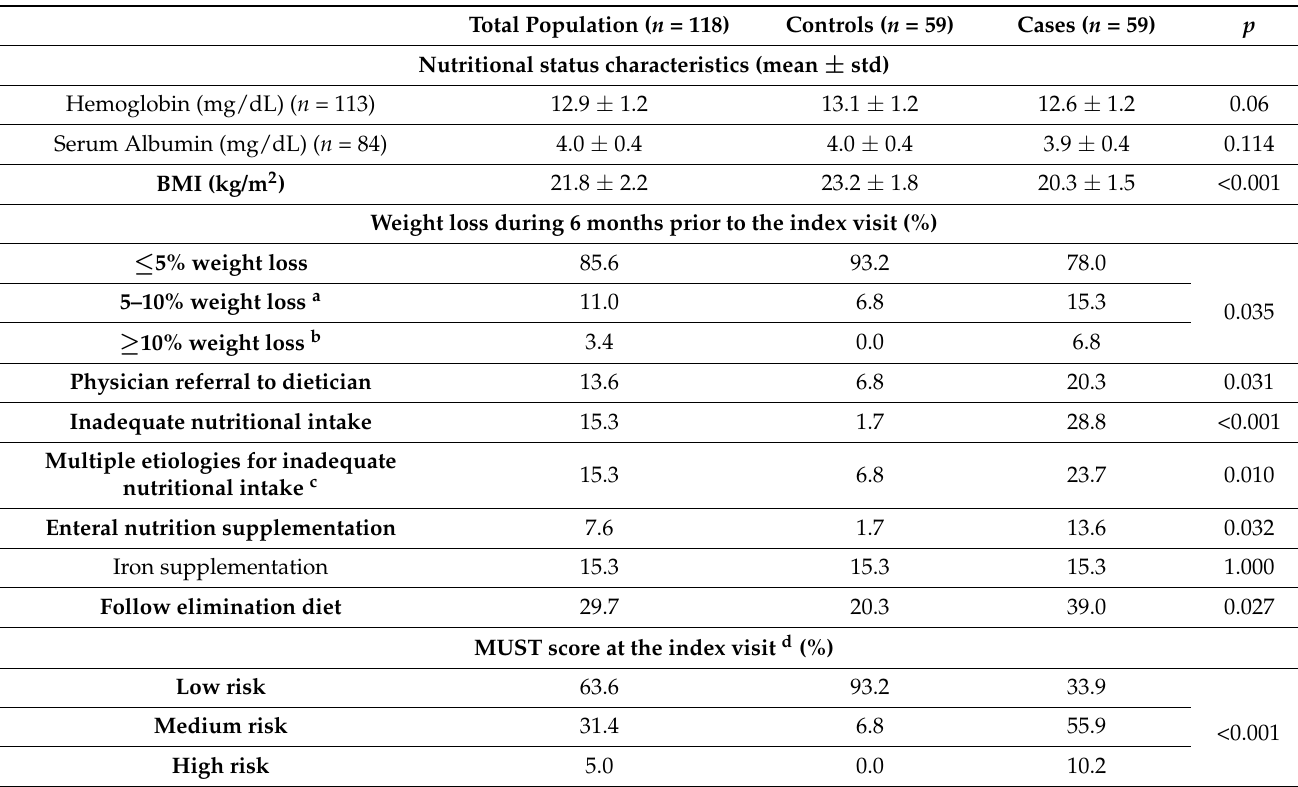
Table 2. Nutritional status and intake characteristics during the index visit. Total Population ( n = 118) Controls ( n = 59) Cases ( n = 59) p Nutritional status characteristics (mean ±